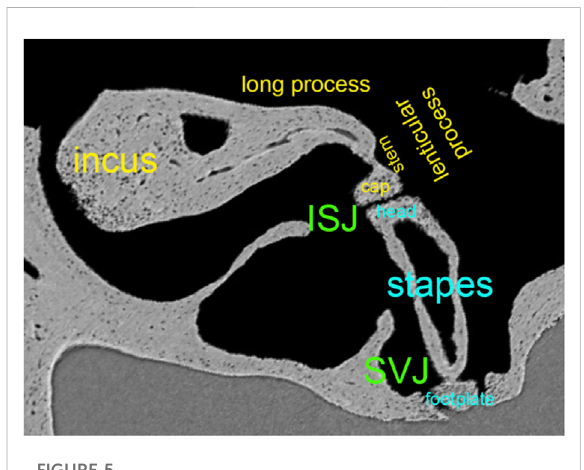
FIGURE 5 Synchrotron x-ray microtomography image from the left ear ’ sincudostapedialjoint(ISJ)andstapediovestibularjoint(SVJ)in a mouse. It shows the stem and cap of the lenticular process, the long process, and the head and neck of the